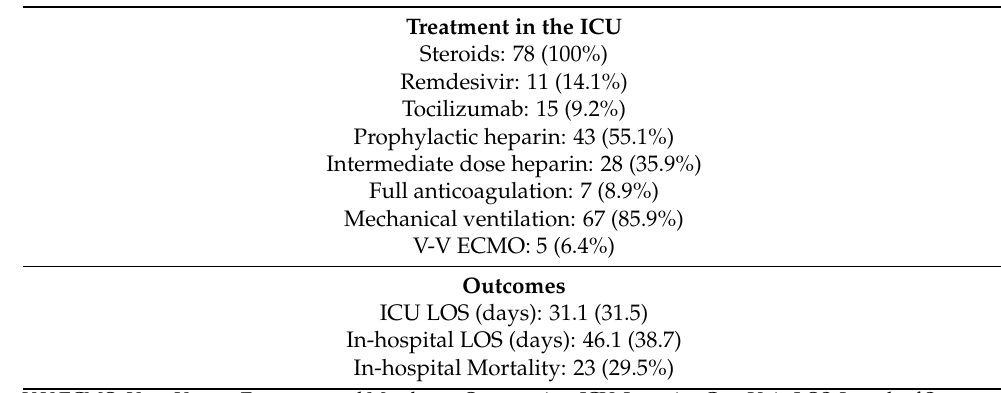
Table 2. Treatments received in the ICU and outcomes.